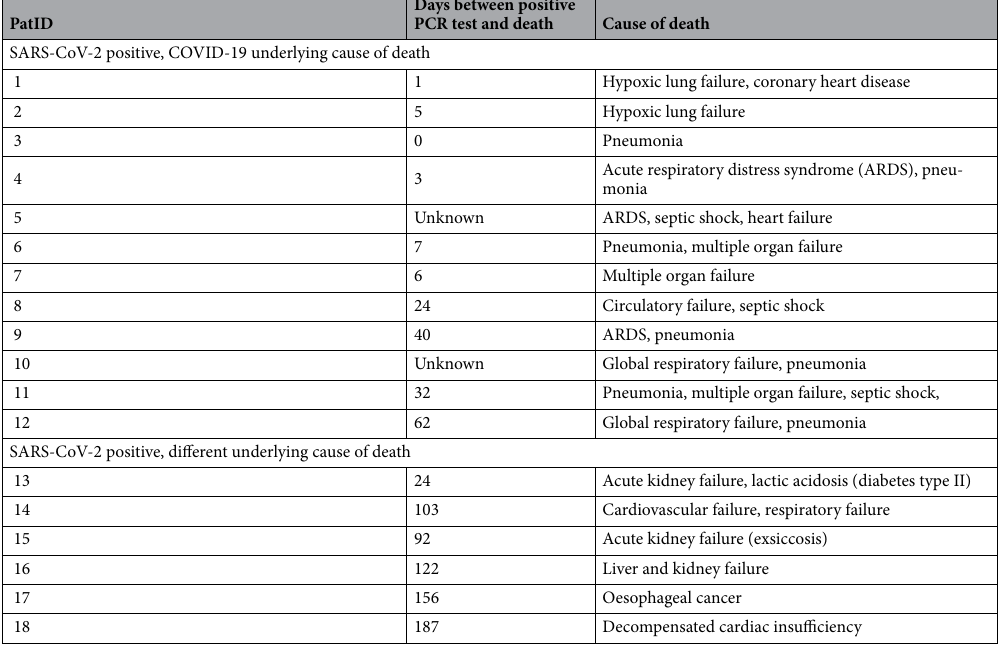
Table 1. All individuals who were SARS-CoV-2 positive and died on COVID-19 underlying and non- COVID-19 underlying causes of death in the studied community. Note that patient 14 was fully recovered from